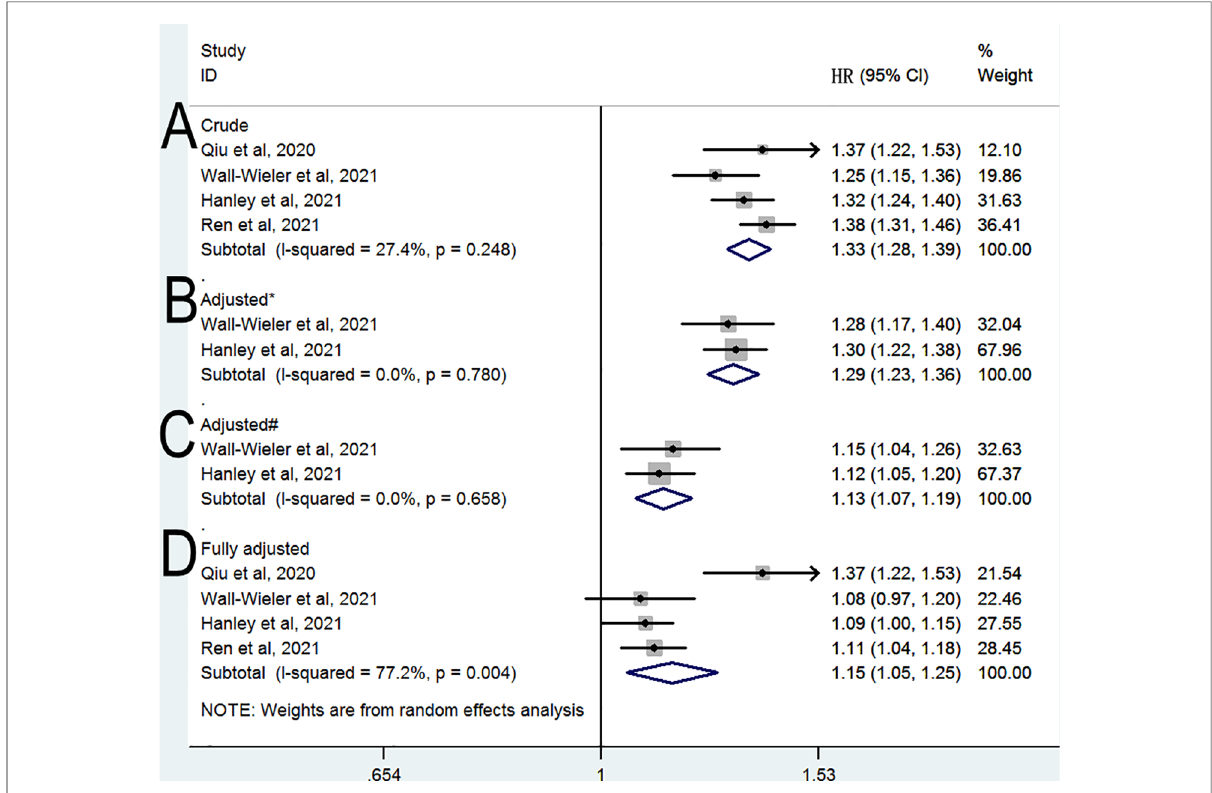
FIGURE 2 Relative risk of subsequent ASD ( A ) crude HR ( B ) HR adjusted for * ( B ) HR adjusted for # ( B ) fully & adjusted HR. * Adjusted for maternal sociodemographic covariates; # Adjusted for maternal sociodemographic, pre-pregnancy and pregnancy-related covariates; & Adjusted for maternal sociodemographic, pre-pregnancy and pregnancy-related, and perinatal